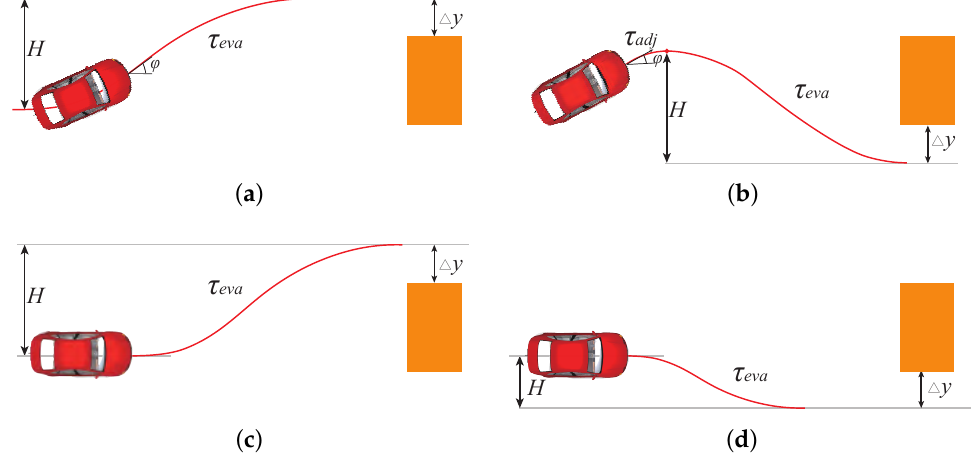
Figure 17. The different cases of calculating t arrive . ( a ) The vehicle faces the direction of the target lateral position. ( b ) The vehicle faces the opposite direction of the target lateral position. ( c ) The vehicle is preparing for a left side evasive maneuver. ( d ) The vehicle is preparing for a right side evasive